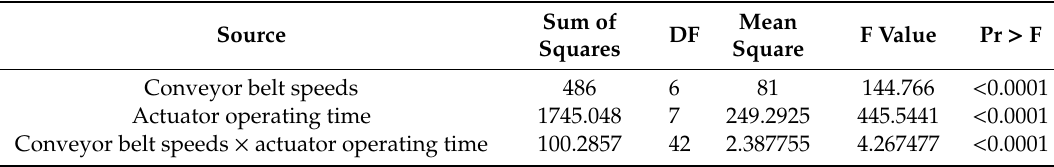
Table 3. Two-way ANOVA table for conveyor belt speeds and operating times of pneumatic- type